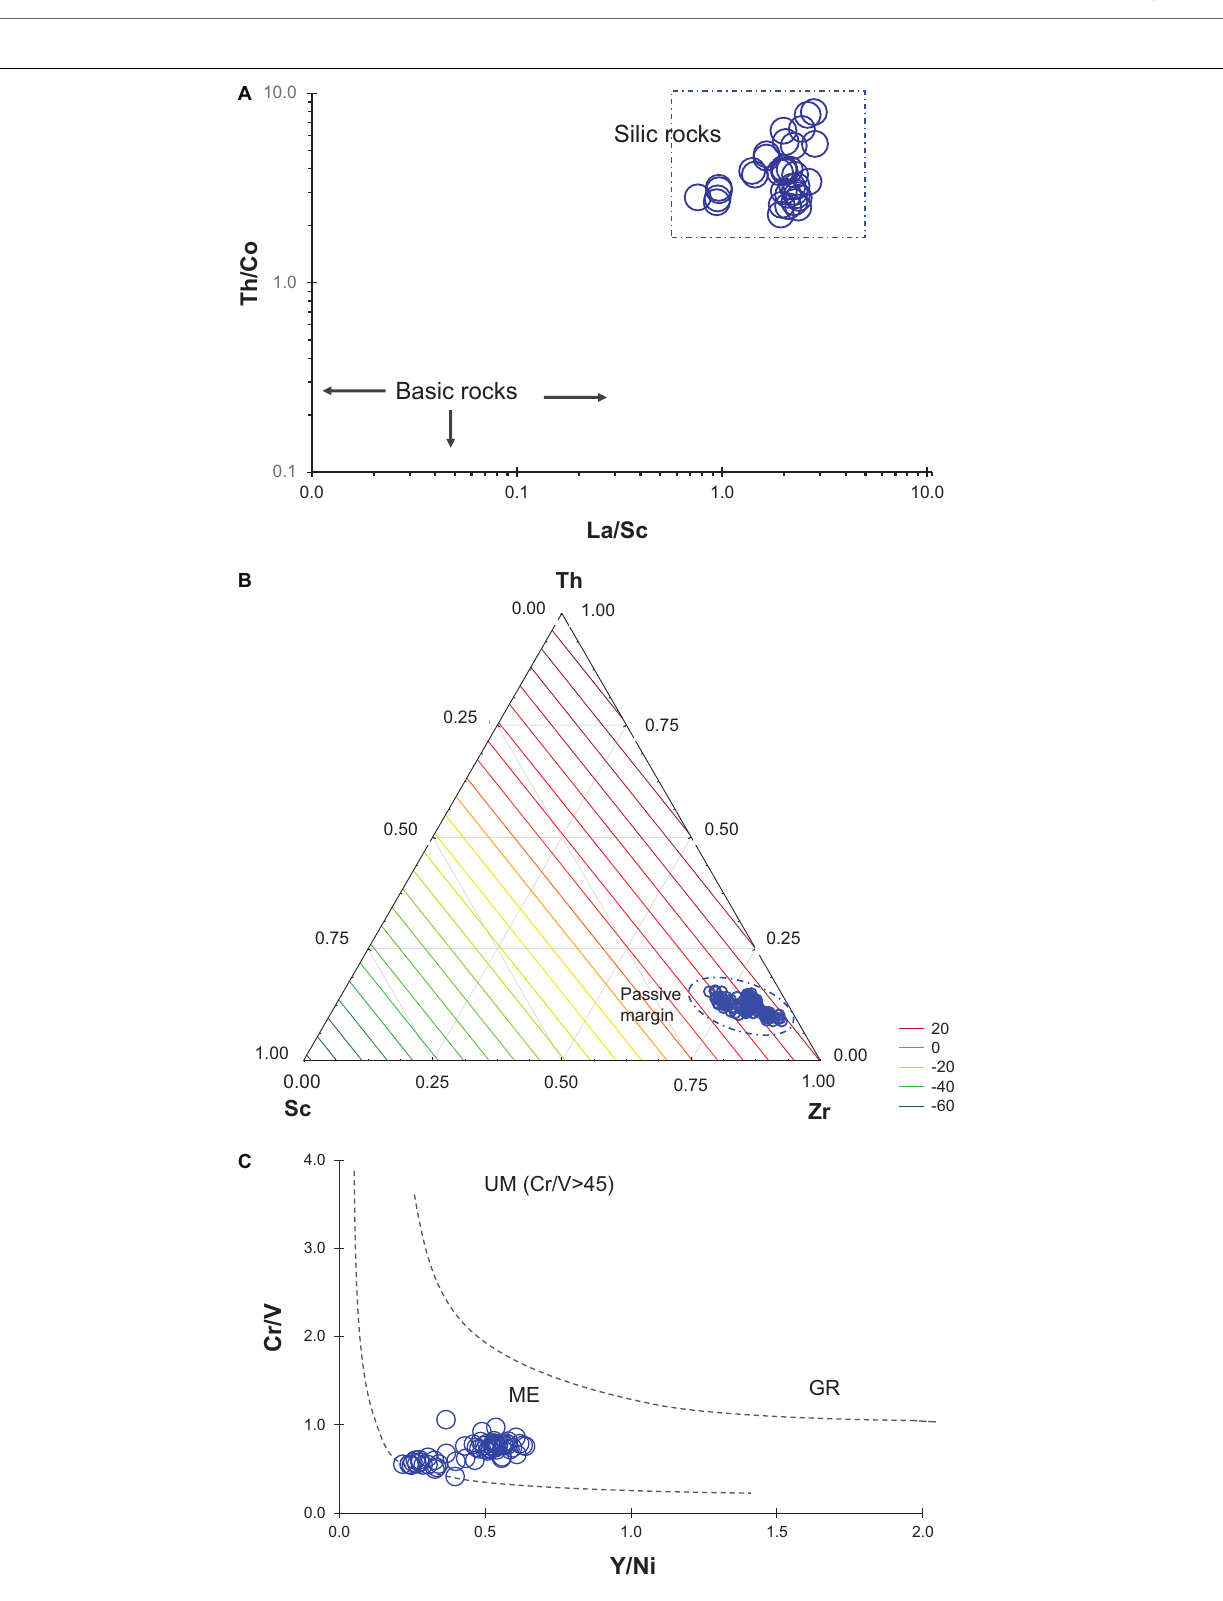
FIGURE 8 | (A) Biplot of La/Sc vs. Th/Co ratio based on Cullers (2002) and Okunlola and Idowu (2012). (B) Zr-Th-Sc ternary diagram based on Bhatia and Crook (1986) and Okunlola and Idowu (2012). (C) Hiscott diagram (Hiscott, 1984) of Cr/V vs. Y/Ni, indicating ultramafic (UM), metamorphic felsic (ME), and granitic (GR) rock